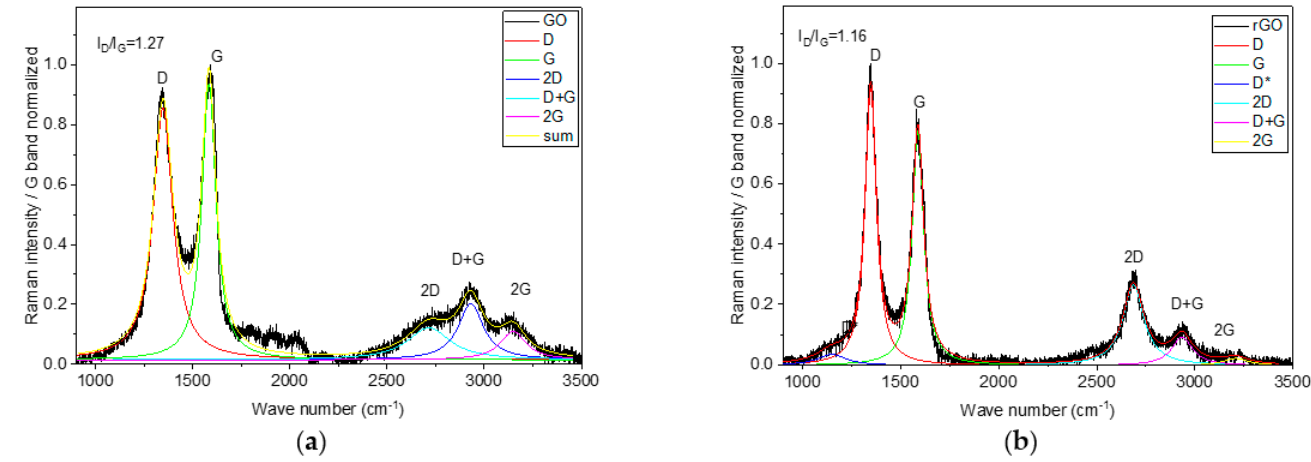
Figure 5. Raman spectrum of ( a ) GO and ( b ) RGO.